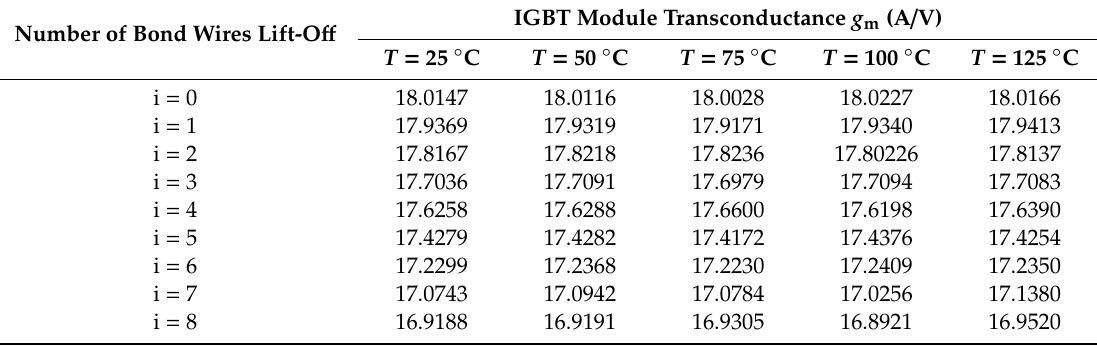
Table 10. Module transconductance of Chip 2 with bond wire failure after temperature normalization. Number of Bond Wires Lift-O